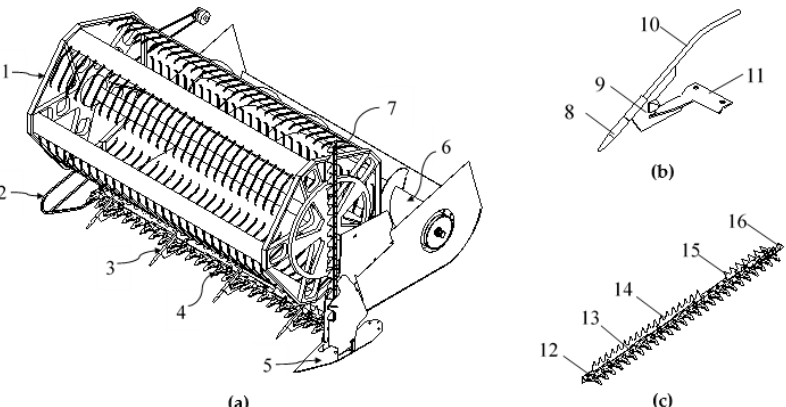
Figure 3. Schematic diagram of the flexible anti pod-dropping seedling-lifting header and its key